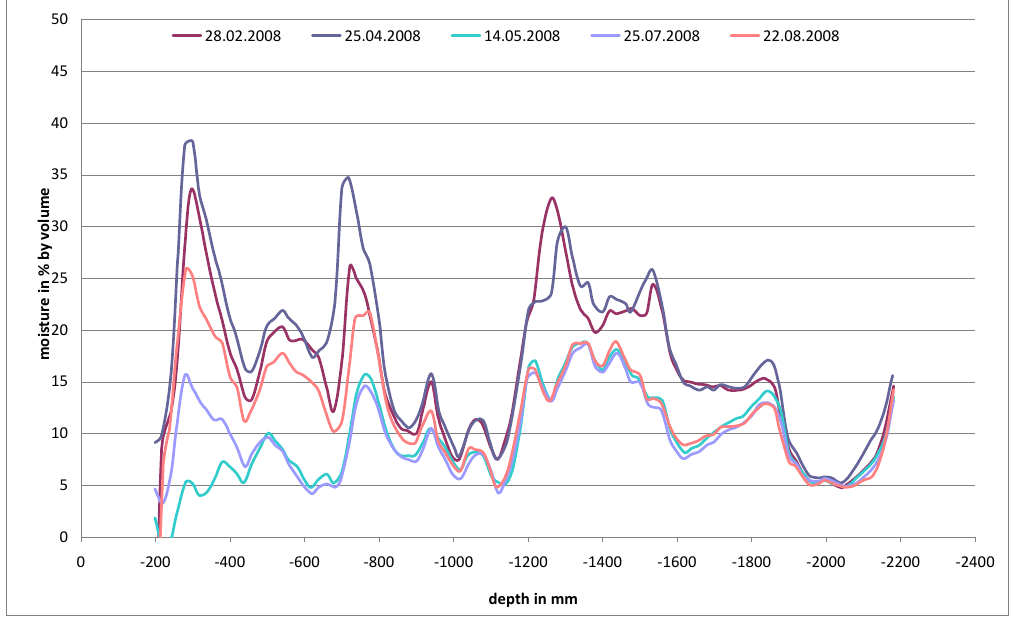
Figure 10 . SM depth profiles of a surface barrier of a waste disposal site recorded with